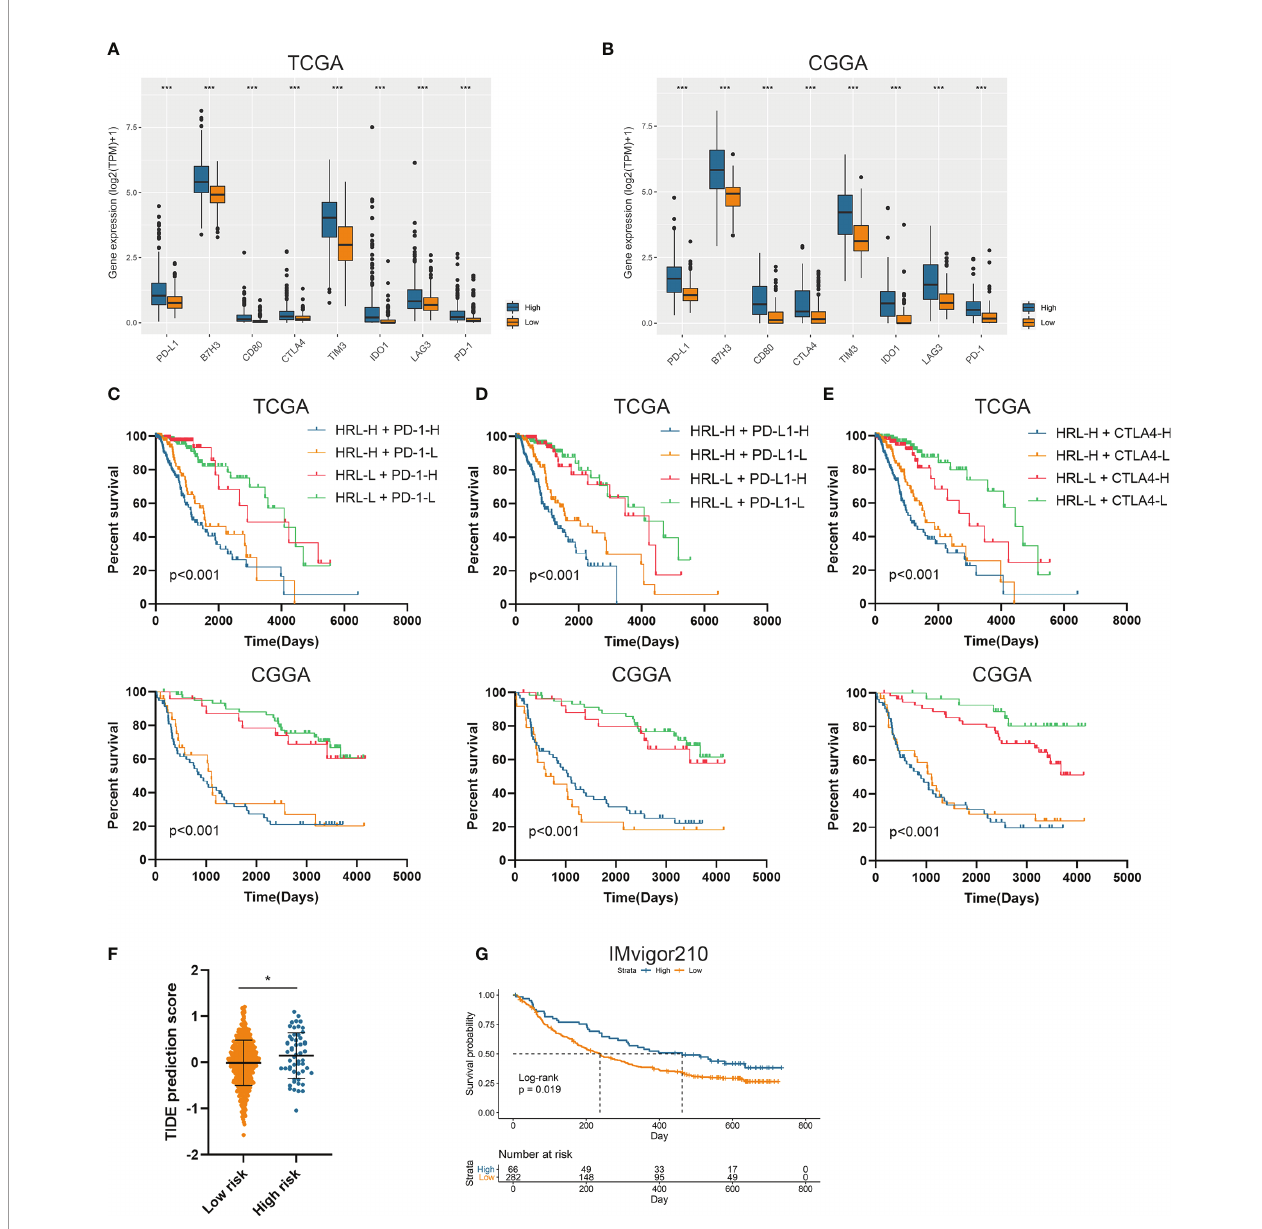
FIGURE 4 | Risk strati fi cation correlated with the ef fi cacy of immunotherapy. (A, B) The expression of several immune checkpoints in high-risk and low-risk groups in the TCGA (A) and CGGA (B) datasets. (C – E) Kaplan-Meier analyses of overall survival among four patient groups strati fi ed by the HRL signature and PD-1 (C) , PD-L1 (D) , and CTLA-4 (E) . (F) TIDE score of high-risk and low-risk groups in TCGA dataset. (G) Kaplan-Meier analysis of urothelial carcinoma patients strati fi ed by HRL signature in IMvigor210 cohort. *p < 0.05, ***p <